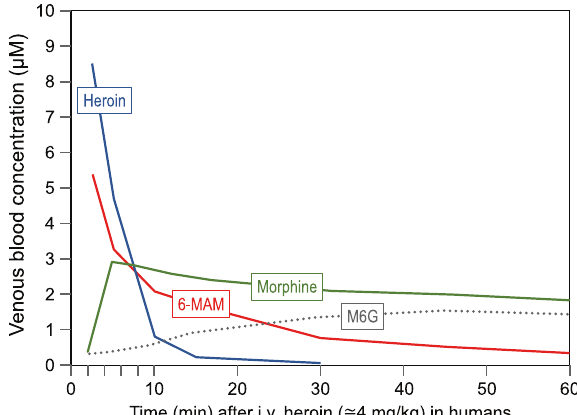
Fig. 3 Pharmacokinetic pro fi le of heroin by i.v. administration and its main metabolites. Time course of venous concentrations of heroin (blue line), 6-MAM (red line), morphine (green line), and M6G (dotted grey line), after an i.v. injection of heroin ( ≅ 4 mg/kg) in humans. Based on data extrapolated from Rook et al. 2006